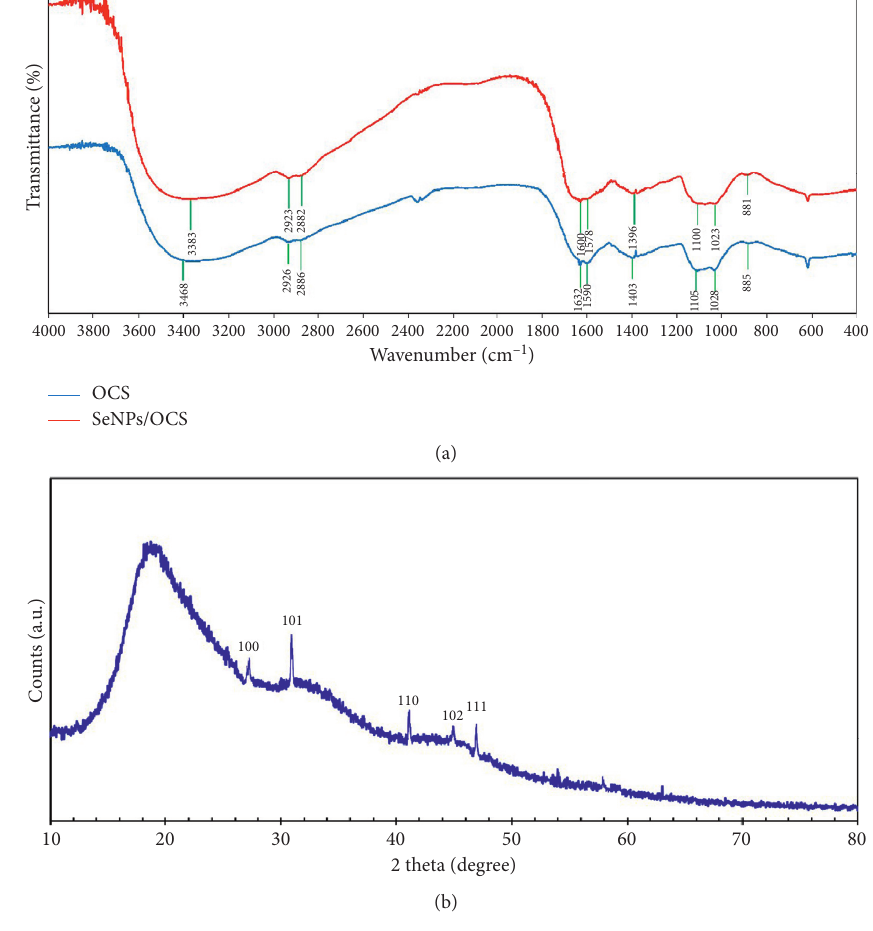
Figure 2: FTIR spectra (a) and XRD patterns (b) of OCS and SeNP/OCS